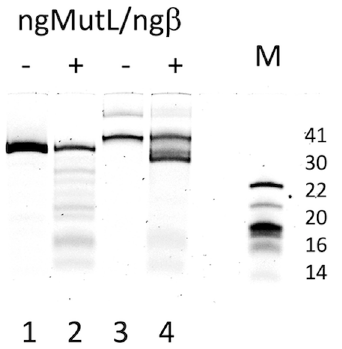
Figure 7. The ngMutL-induced hydrolysis of the DNA substrates (10 nM). The reaction mixtures were incubated in the presence of 0.8 mM ATP, 5 mM MgCl 2 , and 5 mM MnCl 2 for 90 min at 37 °C, and then analyzed in a 12% polyacrylamide gel containing 7 M urea; 0.25 µM ngMutL (per dimer) was used in the presence of an equimolar amount of ng β . Electropherograms of 3 ′ -TAMRA-labeled DNA cleavage products of 76R/76M (lanes 1–2) and 95G4/76M (lanes 3–4) are shown. The lengths of DNA markers, M (in nucleotide residues), are indicated on the right.